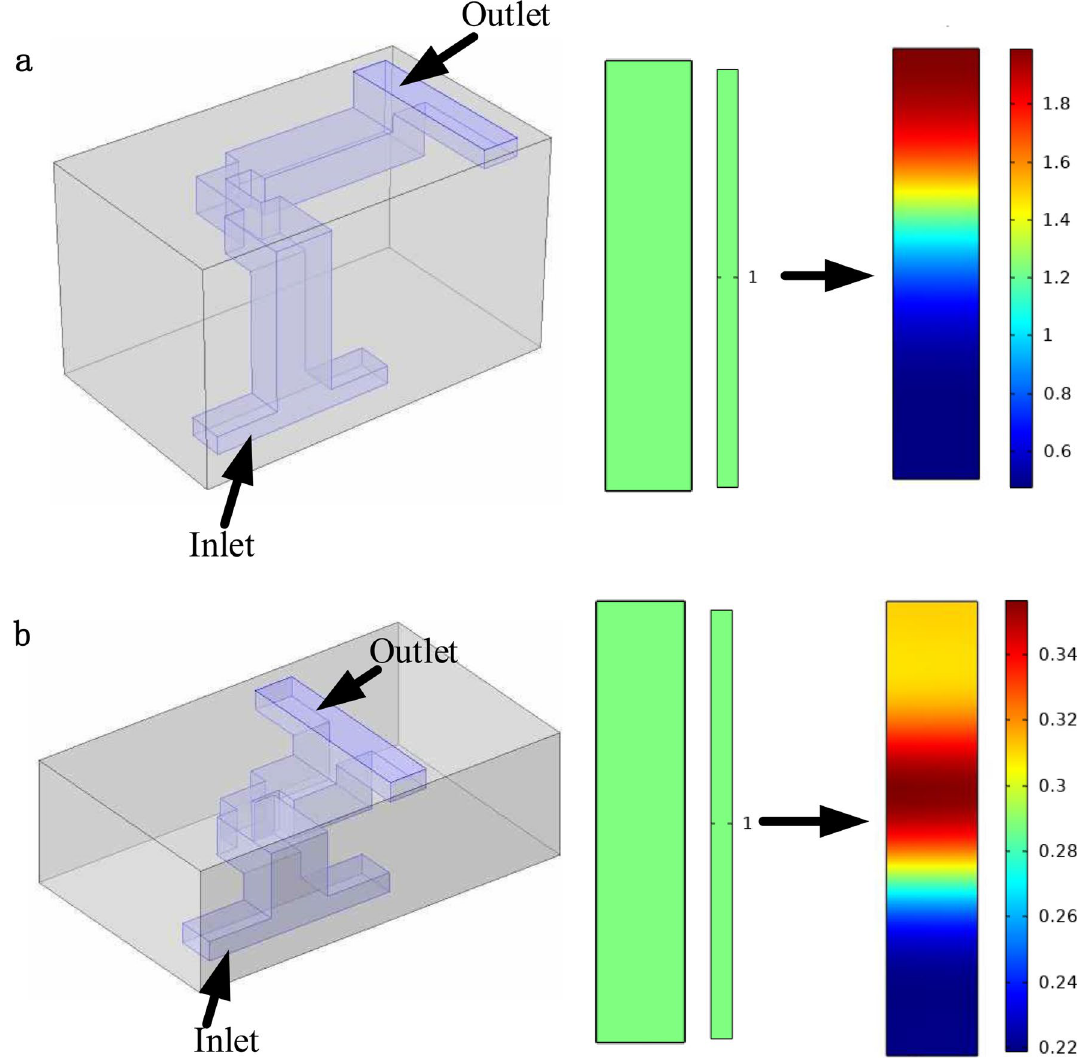
Figure 9. Acoustic pressure distribution at inlet and outlet of two designed unit cells. ( a ) Acoustic pressure distribution at outlet of high pass unit cell. ( b ) Acoustic pressure distribution at outlet of low pass unit